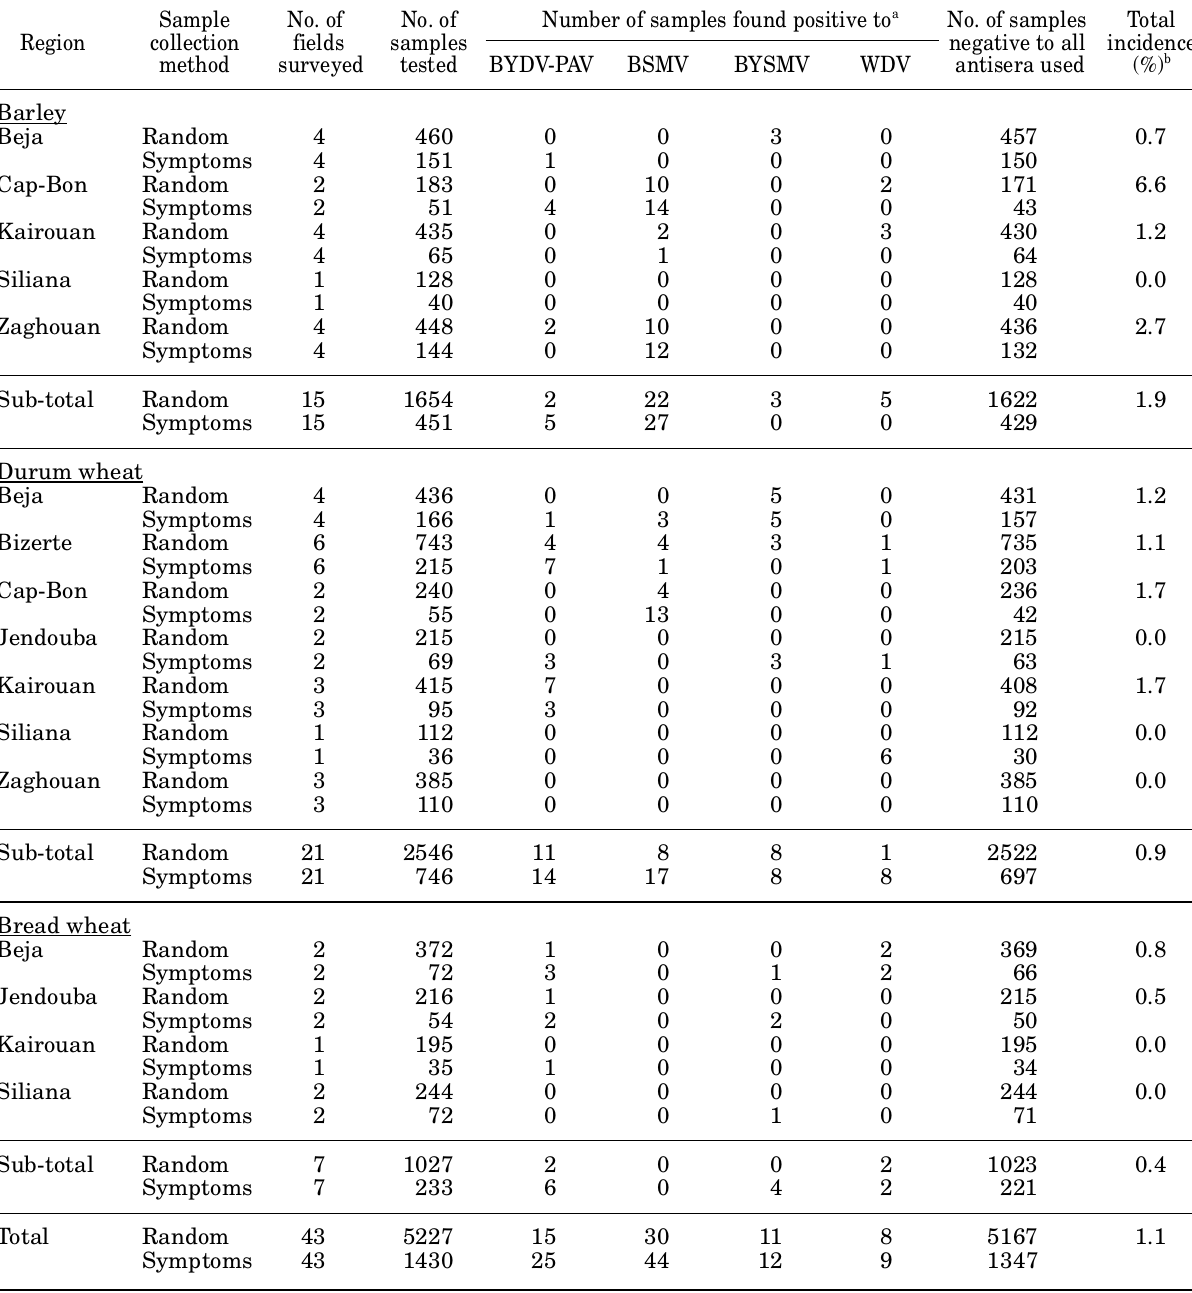
Table 4. Results of laboratory tests on cereal samples randomly collected and with symptoms suggestive of virus infection, from 43 fields in Tunisia, during April, 2000. Viral identification was based on serological reactions (Tis- sue Blot